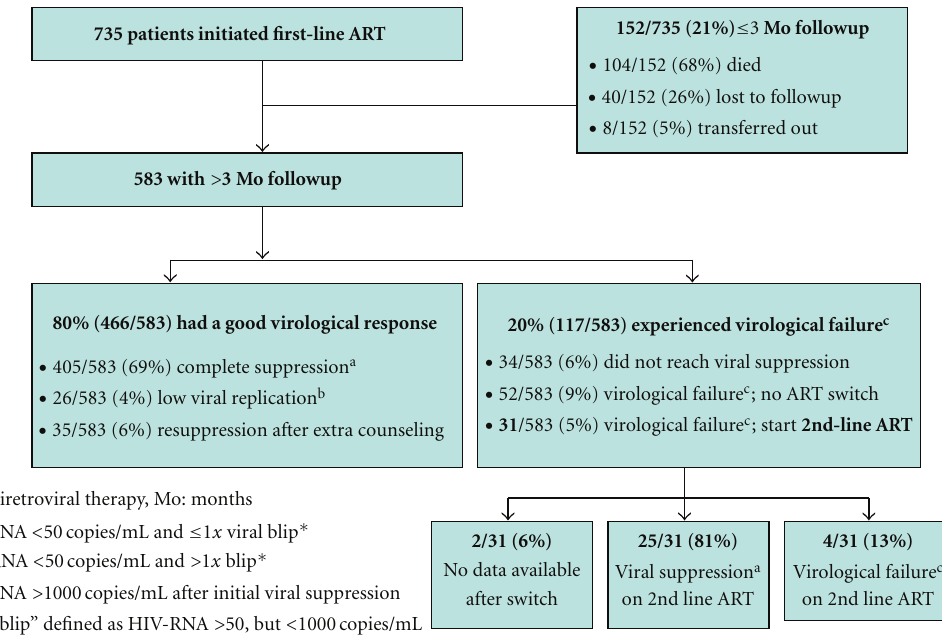
b : HIV-RNA < 50copies/mL and > 1 x blip ∗